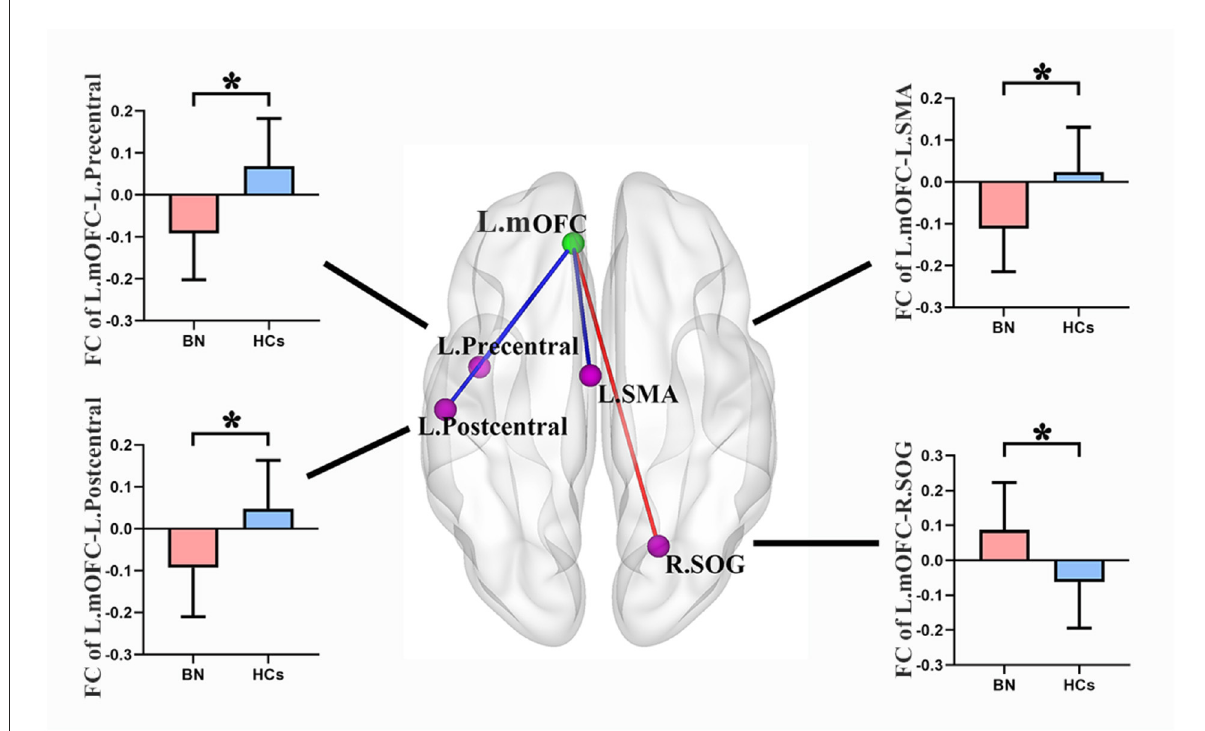
FIGURE2 Compared with healthy controls, the bulimia nervosa group showed significantly increased rsFC between the left mOFC and the rSOG, but decreased rsFC between the left mOFC and the left precentral gyrus, left postcentral gyrus and left SMA (voxel-level P < 0.001 uncorrected and cluster-level P < 0.05 GRF correction). Nodes are color-coded with the seed region (green) and the rsFC differential region (purple). The rsFC between nodes are represented by lines, with red indicating increased and blue indicating decreased. rsFC, resting-state functional